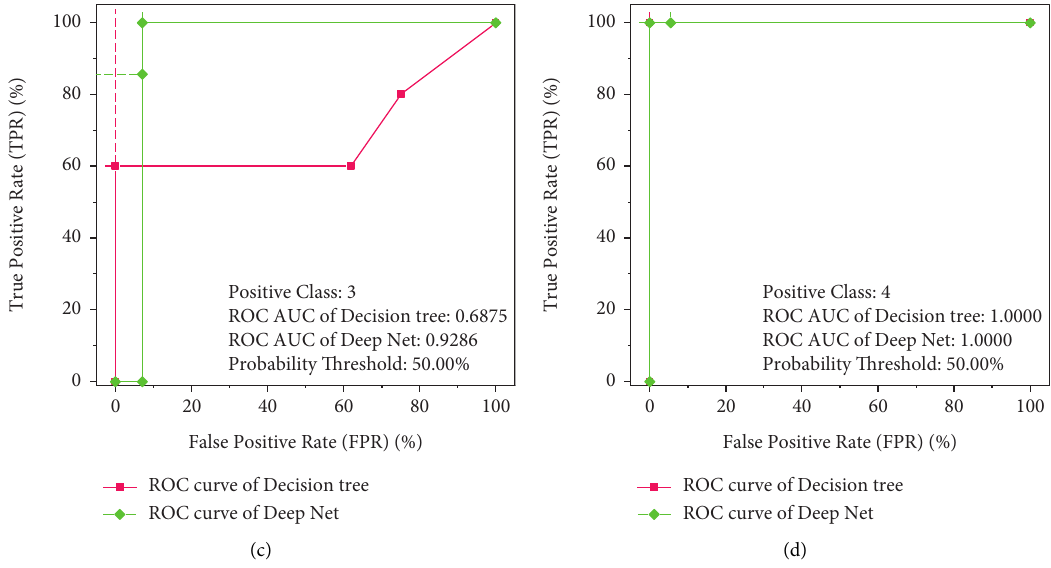
Figure 14: ROC curve of each classification test of the deep network model.